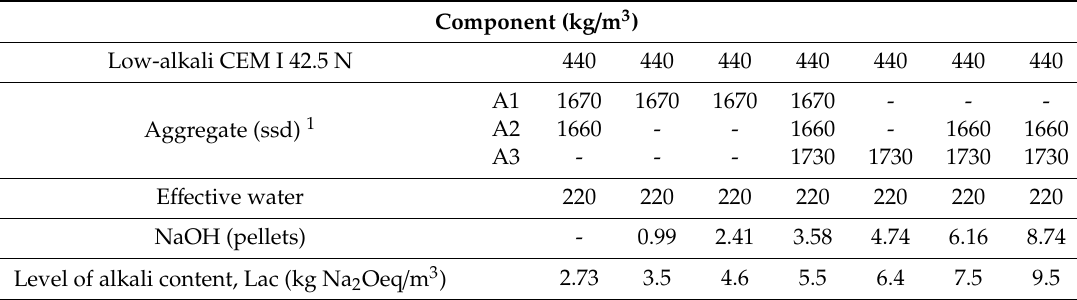
Table 2. Compositions of the concrete mixes